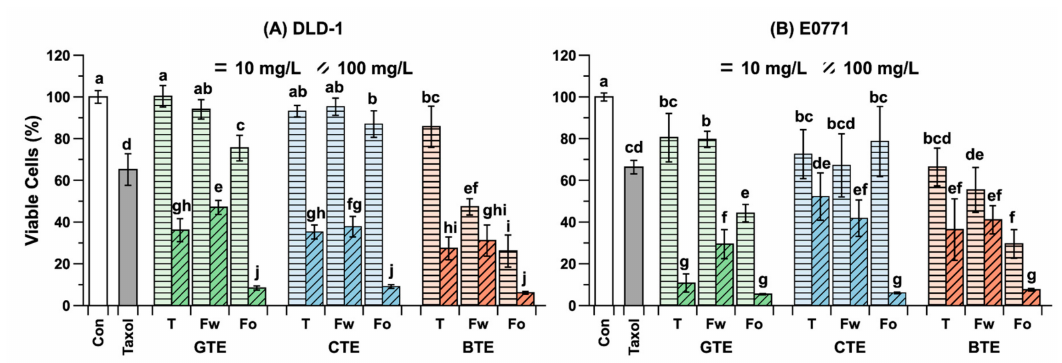
Figure 5. Antiproliferative e ff ects of three tea extracts (GTE, CTE, and BTE) and their fractions. ( A ) Viable DLD-1 cells after 24 h and ( B ) Viable E0771 cells after 24 h. Con = negative control (bu ff er treatment), and Taxol = positive control (paclitaxel, 10 nM). T, Fw, and Fo on the X-axis mean whole extract, W FR , and O FR , respectively. Di ff erent letters a–j on the bars indicate significant di ff erences according to the Tukey–Kramer honestly significant di ff erence test ( p <